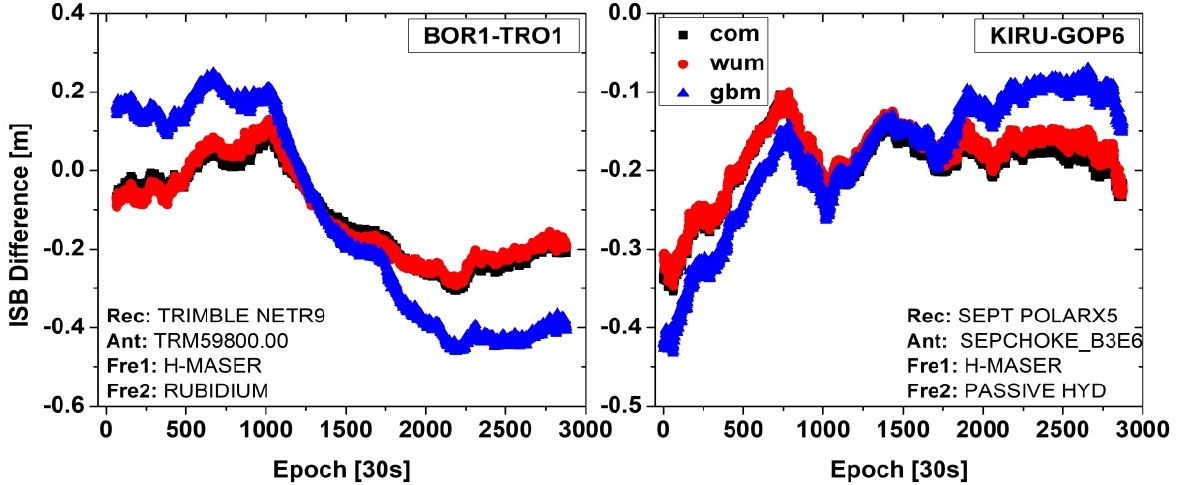
Figure 7. ISB difference series for scheme 4 on DOY 115, 2021.